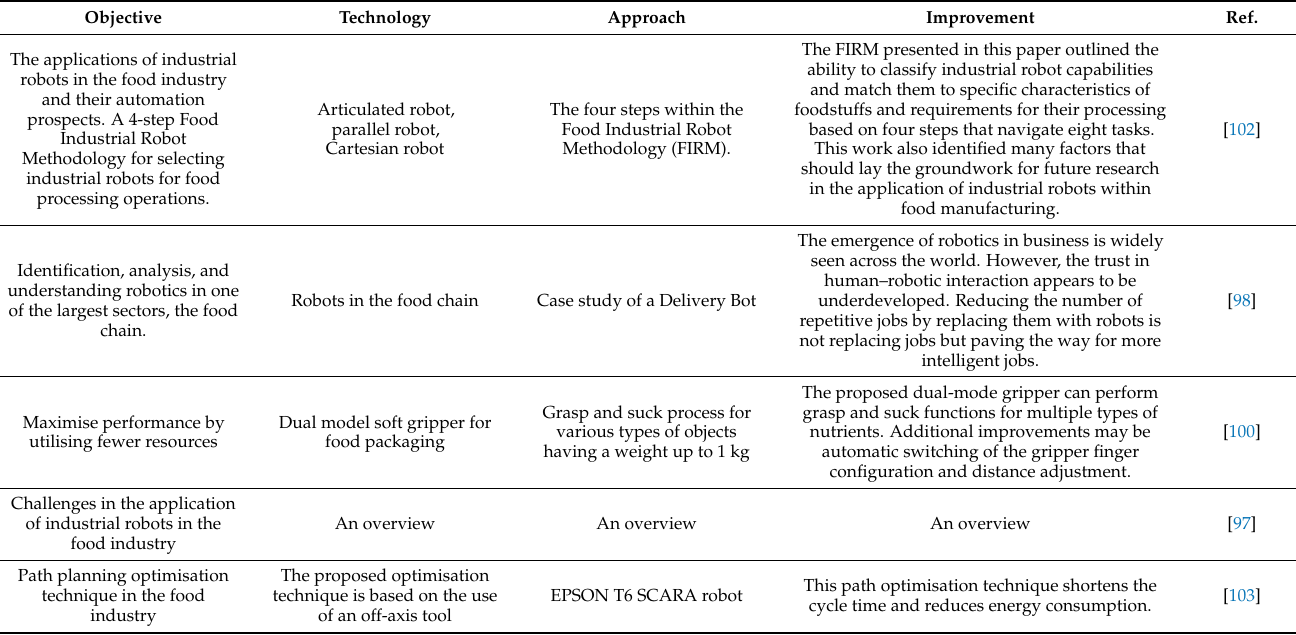
Table 6. Research focused on the food